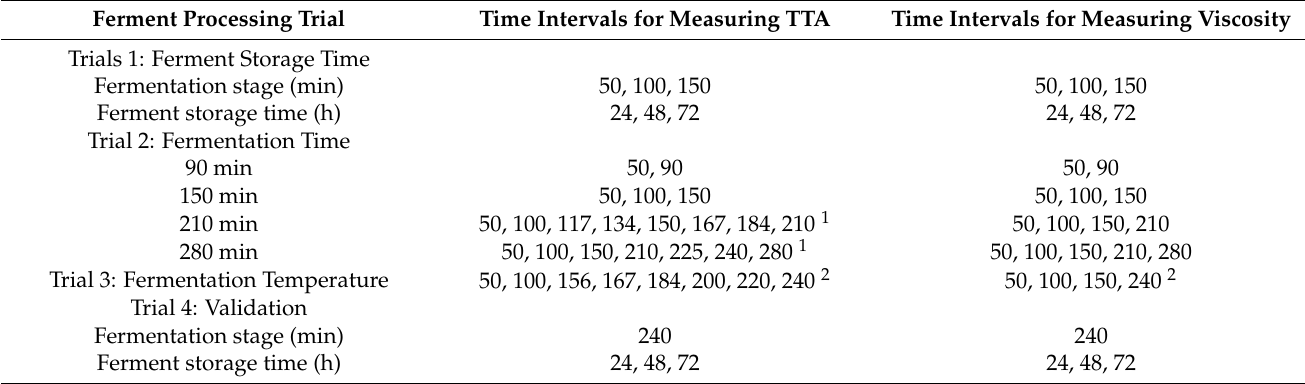
Table 4. Sampling intervals for measuring TTA and viscosity during each ferment processing trial. Ferment Processing